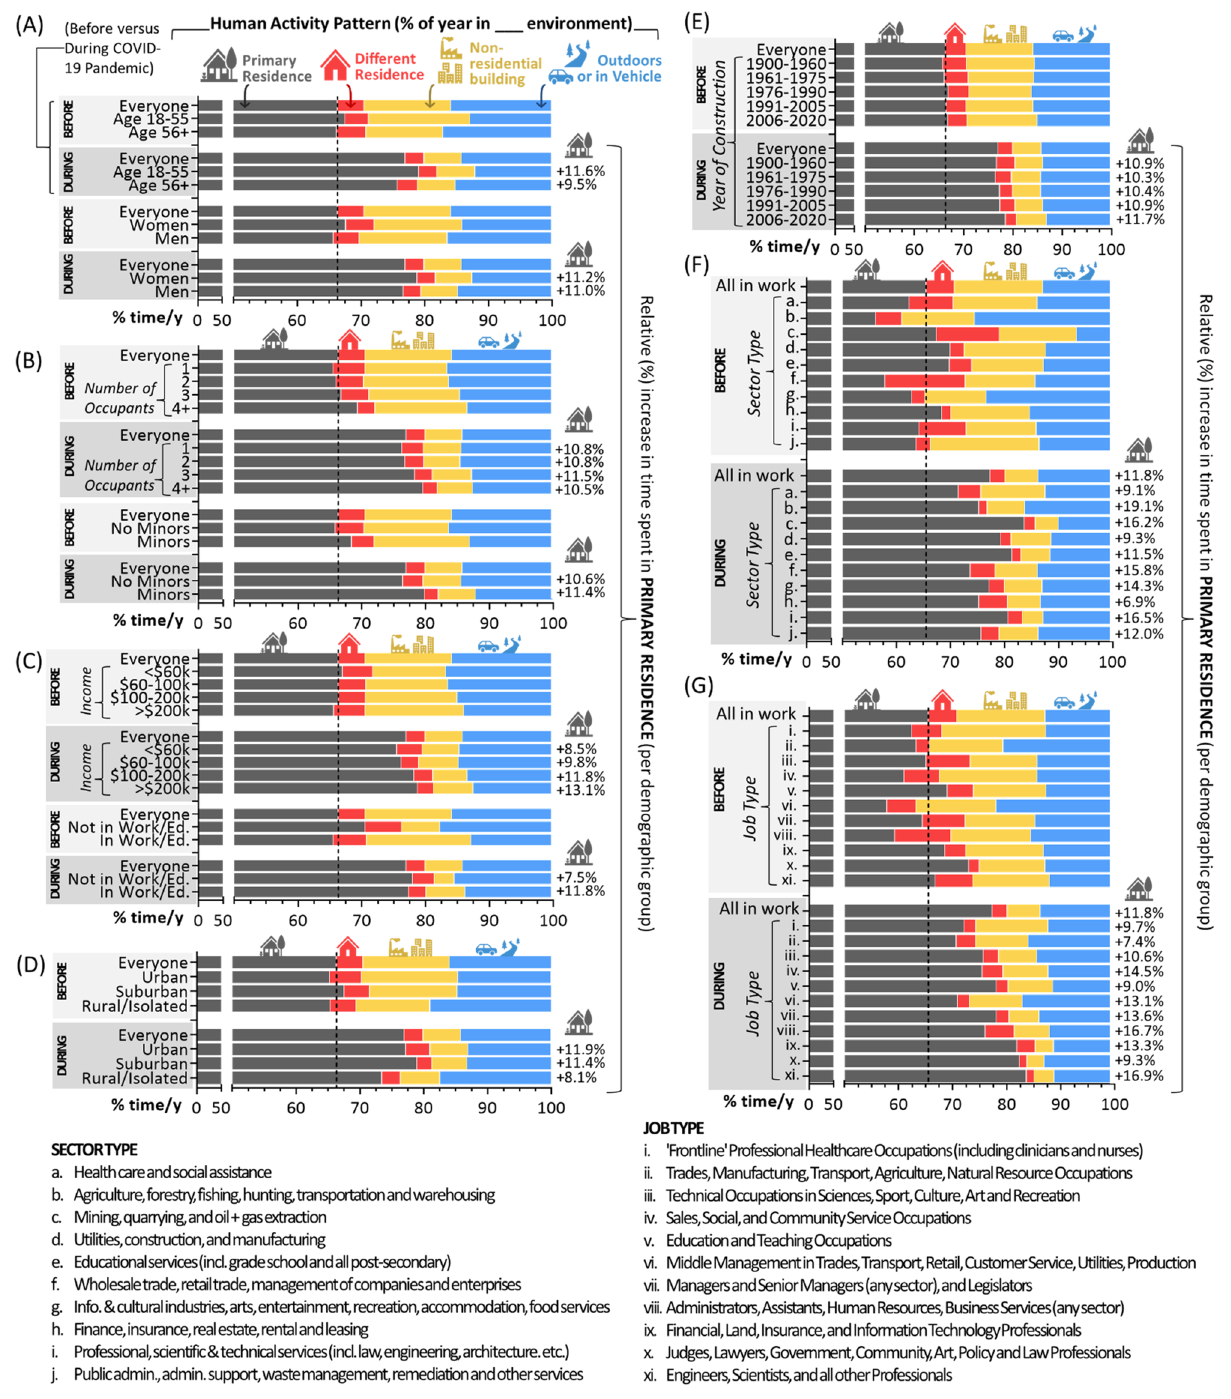
Figure 3. Activity patterns pre- and post-pandemic as a function of population demographics. In all cases, “everyone” refers to the total population for whom the specific demographic variable data was available. Panel A . Activity pattern by age and gender. Panel B . Household occupants and presence of minors. Panel C. Household income and work status of the primary respondent. Panel D . Primary residence community type. Panel E . Year of primary residence construction. Panel F . Sector of employment of the primary respondent, with legend shown below indicating sectors ‘a-j’. Panel G . Job of the primary respondent, with legend shown below showing jobs ‘i–xi’. Figures were prepared using Excel and GraphPad Prism 9.1.1 (225) (www. graph pad.